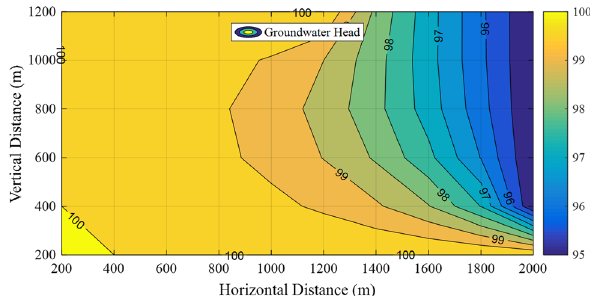
Fig. 7 Groundwater head distribution after 5 years